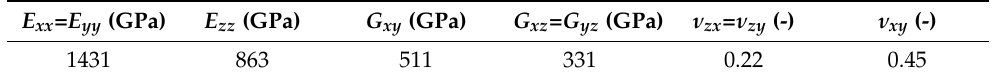
Table 3. Compliance matrix coefficients.